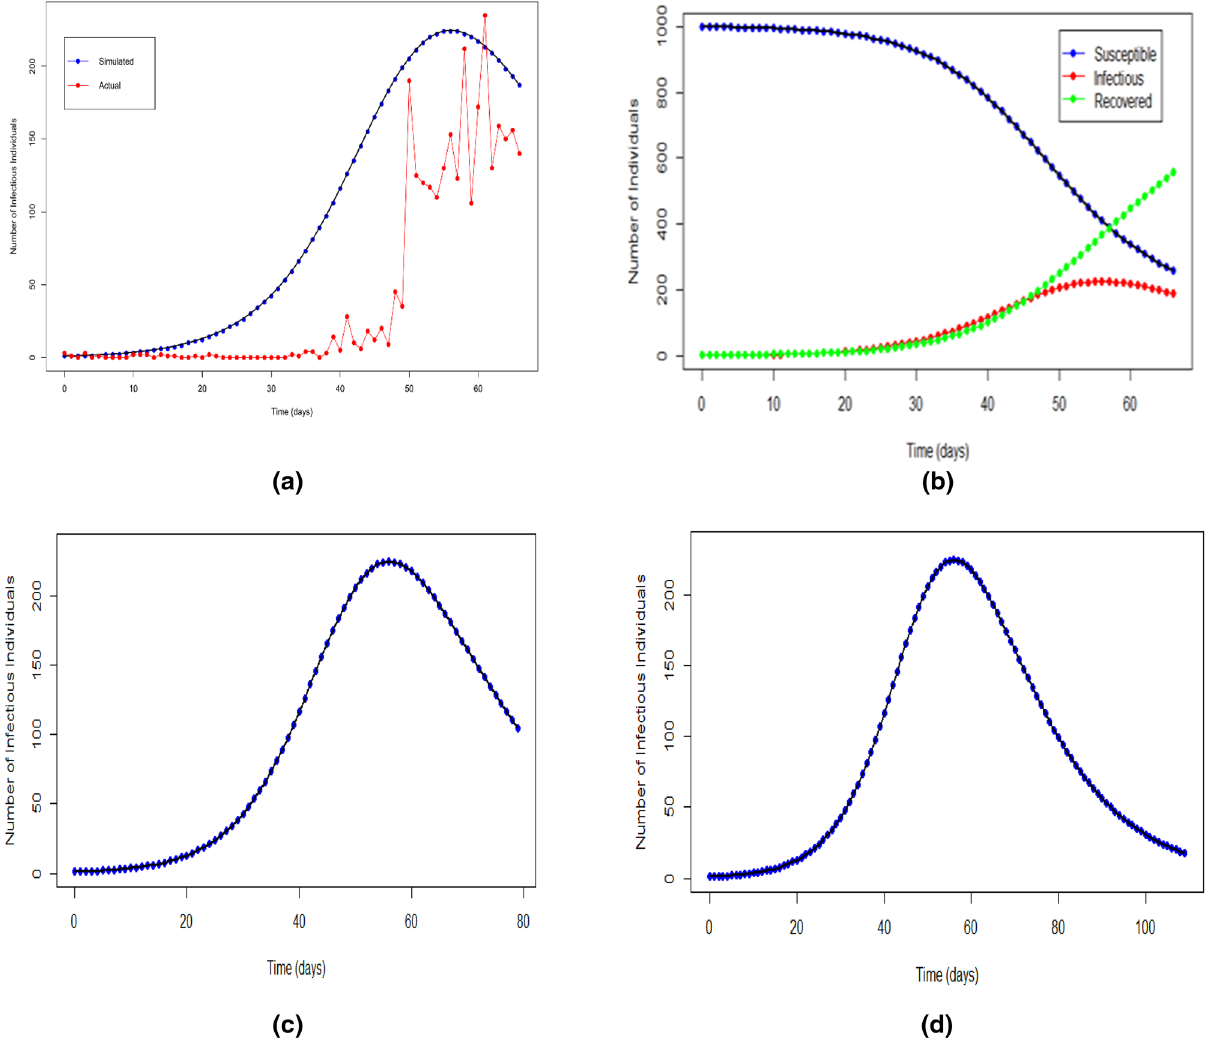
Figure 2. The actual and simulated infectious trend. ( a ) For 67 days, ( b ) simulated SIR compartments, ( c ) simulated projection of 80 days trajectory, ( d ) simulated projection of 110 days